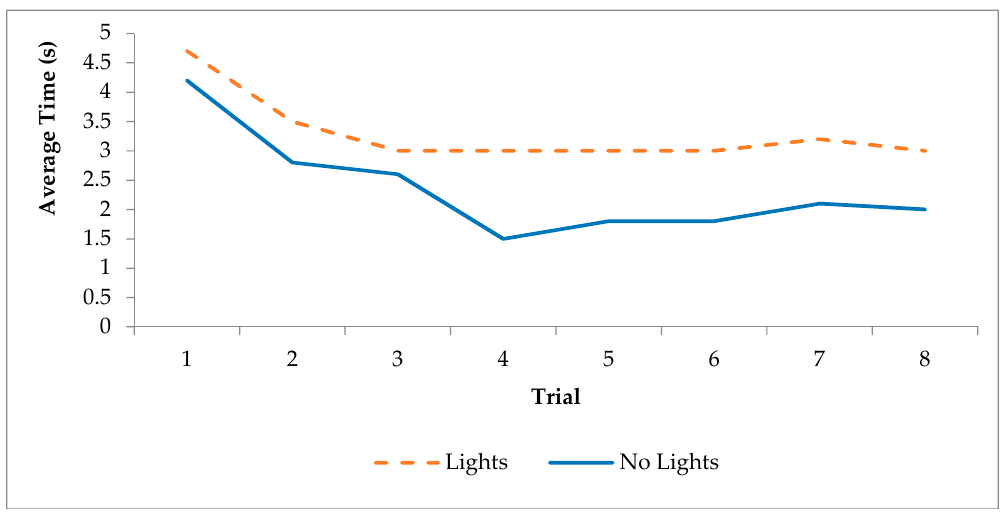
Figure 8. Time to complete tasks in trial one. Times for trials with and without lights are compared to a baseline condition (in which participants picked up the jug as soon as they were instructed by the experimenter).